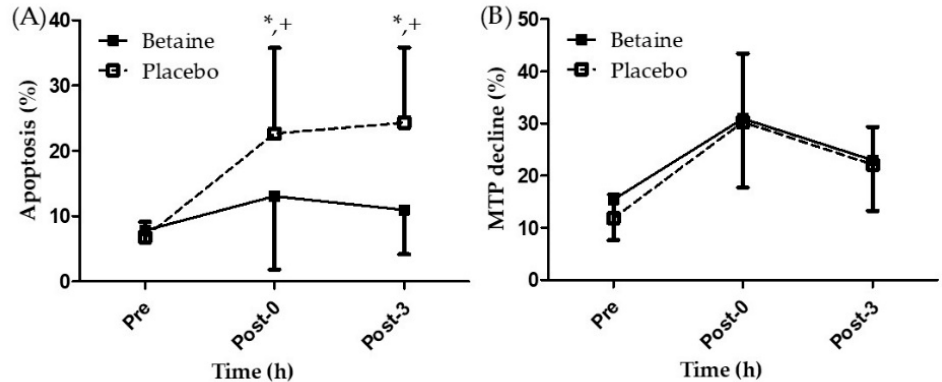
Figure 4. Changes of ( A ) lymphocyte apoptosis and ( B ) mitochondrial transmembrane potential decline in the exhaustive exercise after 2 weeks of betaine supplementation. * Significant ( p < 0.05) di ff erence from Pre. + Significant ( p < 0.05) di ff erence from betaine. Pre, before exercise; Post-0, immediately after exercise; Post-3, 3 h after exercise.